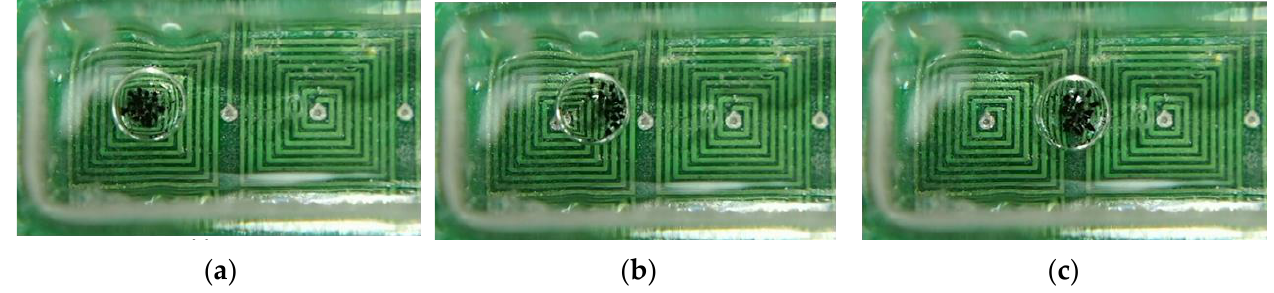
Figure 9. A series of photographs depicting a droplet actuating from ( a ) intial postion, ( b ) movement,